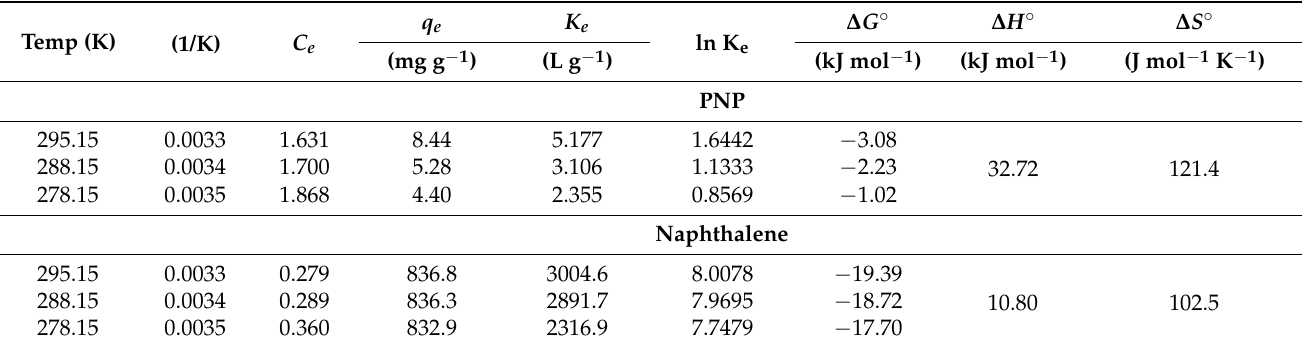
Table 3. Thermodynamic parameters for ferric sulfate coagulation process for PNP and naphthalene.